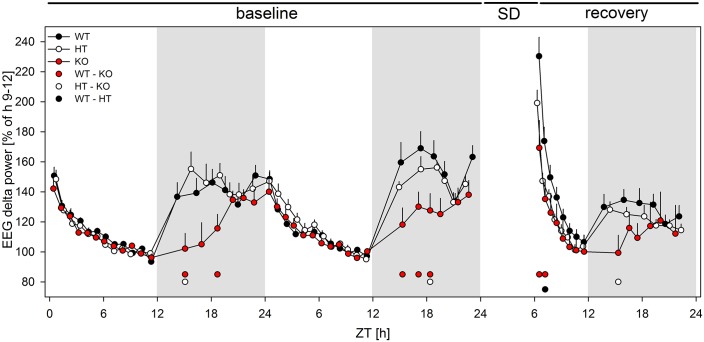
Lack of mGluR5 causes marked changes in EEG marker of sleep homeostasis in mice.Time course of the EEG delta power across the 48 hr baseline and 18 hr of recovery (n = 7–8/genotype), expressed as a percentage of the genotype-specific mean reference value at baseline (ZT8 - ZT12). Dots above the x-axes denote significant differences between WT and KO animals (red), HT and KO (white) animals, and WT and HT animals (black), respectively. pall < 0.05 (2-sided t-tests), following significant one-way ANOVAs (per time point, factor 'genotype').10.7554/eLife.28751.018Figure 7—source data 1.Excel file with one data sheed containing the numerical values of Figure 7.